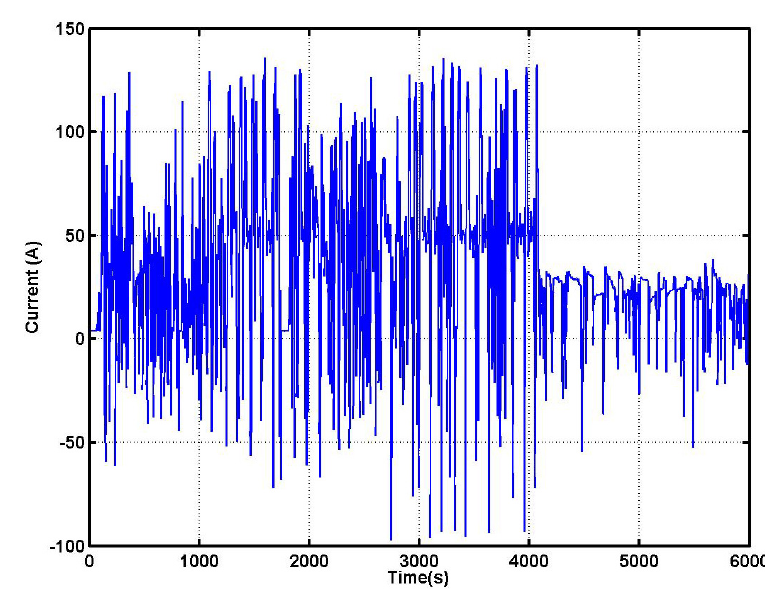
Figure 17. Current curve.